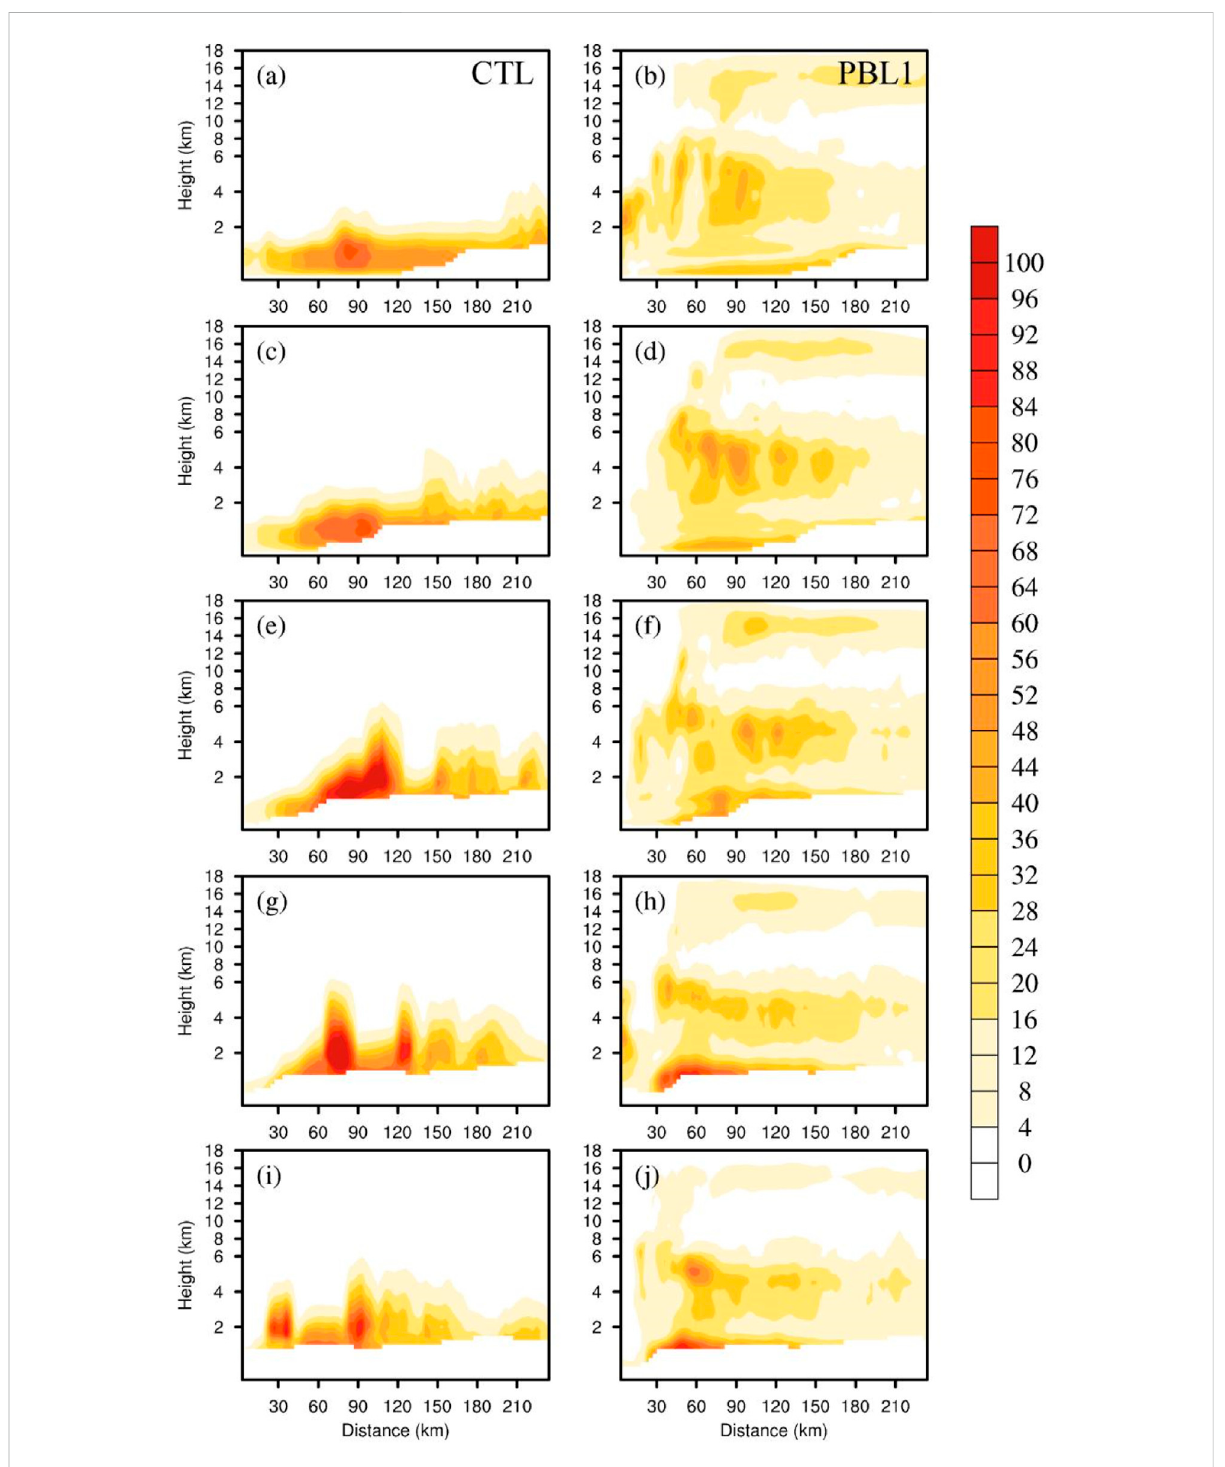
FIGURE 14 Height – radius distribution of azimuthal-mean eddy diffusivity for momentum (unit: m 2 /s) from (A,C,E,G,I) CTL and (B,D,F,H,J) PBL1 at (A,B) 12: 00 UTC on 9 August, (C,D) 15:00 UTC on 9 August, (E,F) 18:00 UTC on 9 August, (G,H) 21:00 UTC on 9 August, and (I,J) 00:00 UTC on 10 August 2019. The y -axis is for height above ground (0 m). The white areas below the height of 2 km denote missing